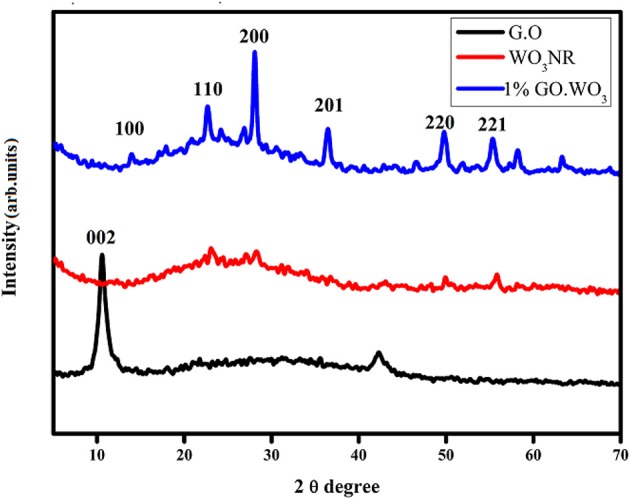
XRD patterns of GO, WO3, 1%GO.WO3 catalysts.